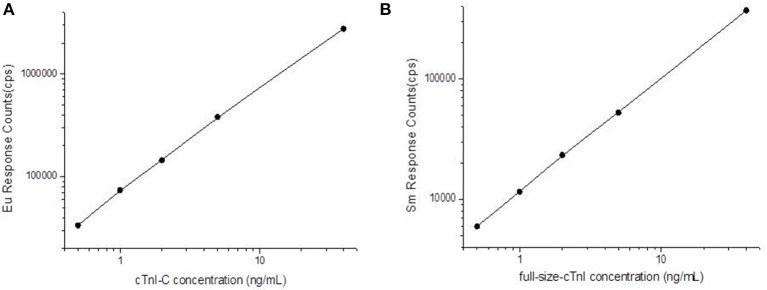
Full-size-cTnI/cTnI-C-TRFIA standard curves. (A) TRFIA standard curve of cTnI-C complex. (B) TRFIA standard curve of full-size-cTnI.